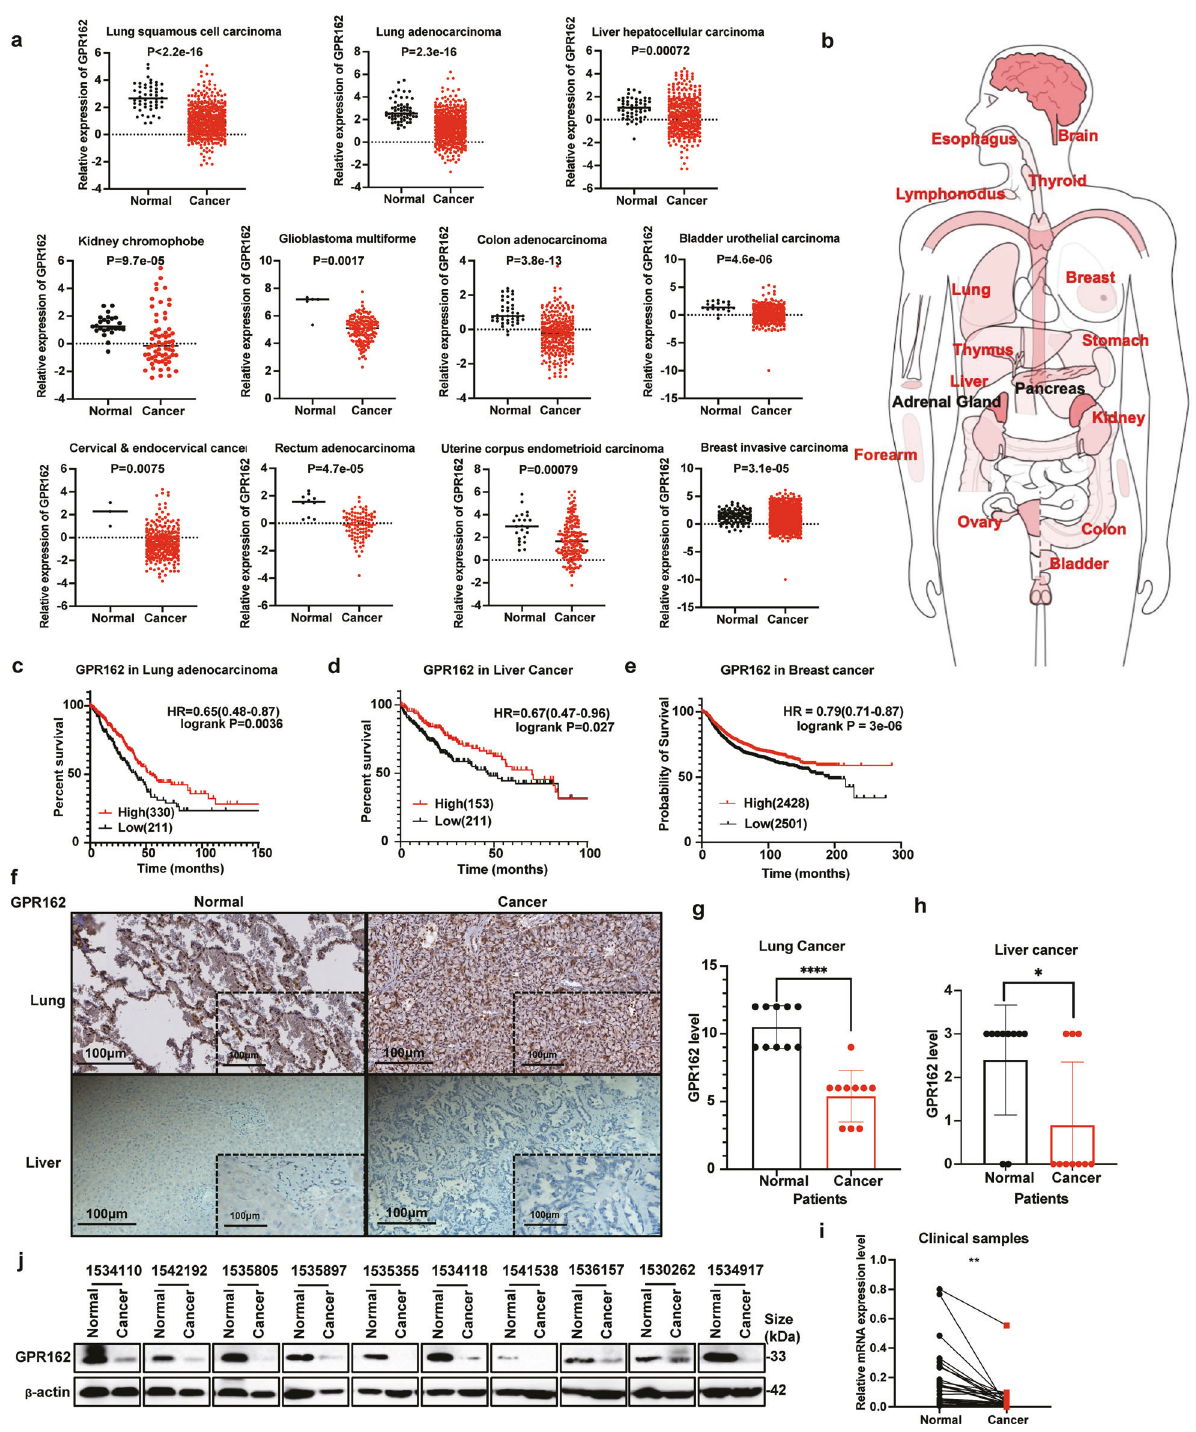
Fig. 5 GPR162 is lowly expressed in multiple types of cancer. a TCGA analysis of GPR162 mRNA expression in lung squamous cell carcinoma, lung adenocarcinoma, liver hepatocellular carcinoma, kidney chromophobe, glioblastoma multiforme, colon adenocarcinoma, bladder urothelial carcinoma, cervical & endocervical cancer, rectum adenocarcinoma, uterine, corpus endometrioid carcinoma, and breast invasive carcinoma compared to each normal sample. Each dot represents a sample. b Human models showed low expression of GPR162 in most solid tumors. Body image from Gene Expression Pro fi ling Interactive Analysis . c – e In lung adenocarcinoma ( c ), liver cancer ( d ), and breast cancer ( e ), Kaplan – Meier curves demonstrate overall survival rates related to GPR162 expression. The log-rank test was used to evaluate the results. f IHC analysis of GPR162 expression level in lung adenocarcinoma and liver cancer clinical samples. g , h GPR162 expression levels are higher in lung adenocarcinoma ( g ) and liver cancer ( h ) tissues than in normal tissues, according to IHC scores. i mRNA expression of GPR162 was found to be lower in 30 paired lung cancer tissue samples compared to neighboring normal lung tissue samples by qPCR. Each dot represents a different sample. j The protein level of GPR162 was found to be lower in 10 paired lung cancer tissue samples compared to neighboring normal lung tissue samples from western-blot analysis. (* p < 0.05, ** p < 0.01, **** p < 0.0001)